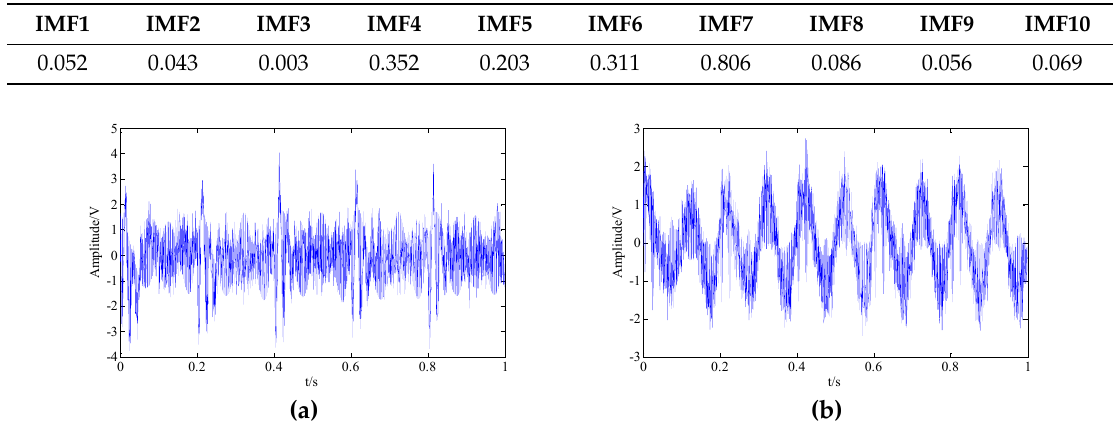
Table 1. The correlation coefficient between each IMF and the simulation signal.